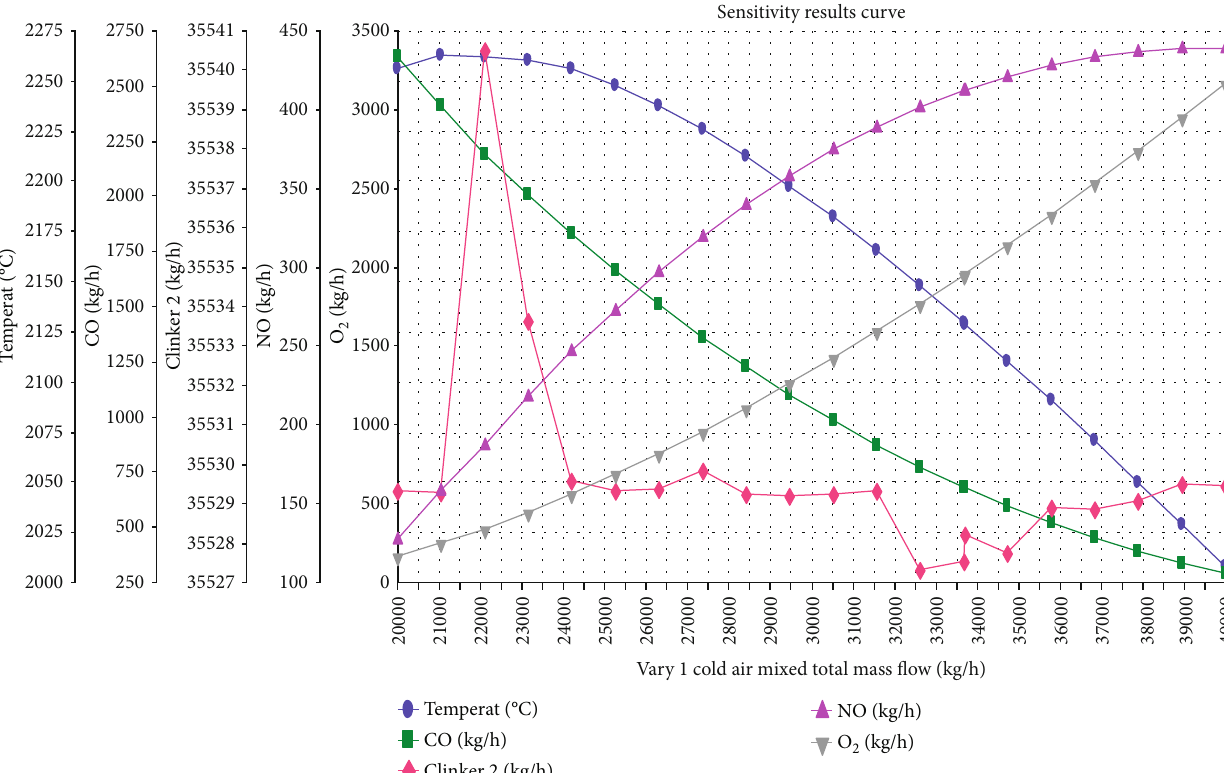
Figure 7: Cooling air vs. clinker production and combustion